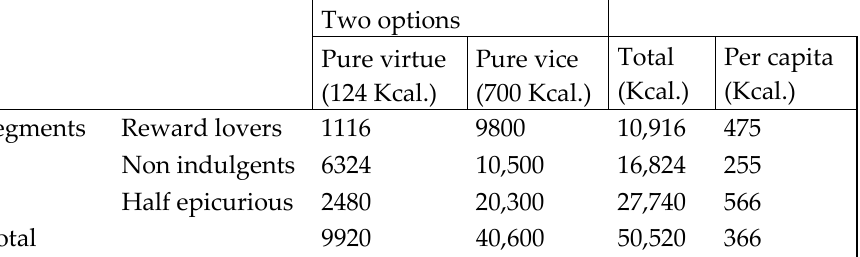
Table 5. Segments food choice. Five options bundle